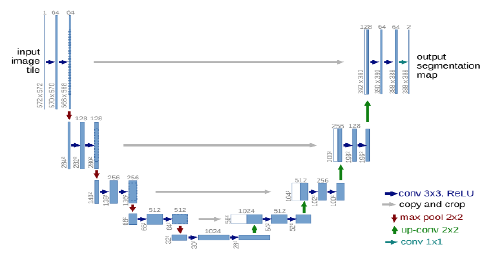
Figure 2. U-Net architecture (Ronneberger et al., 2015)